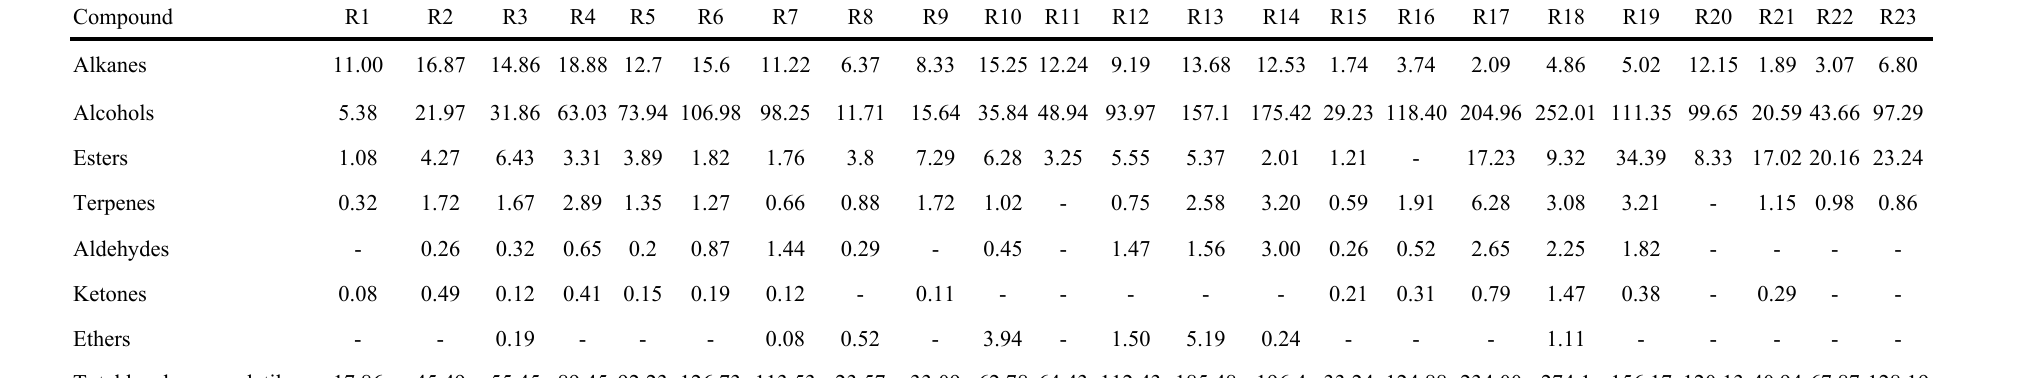
Table 3. Aromatic categories and total headspace volatiles of 23 R. rugosa germplasms ( μ g·g -1